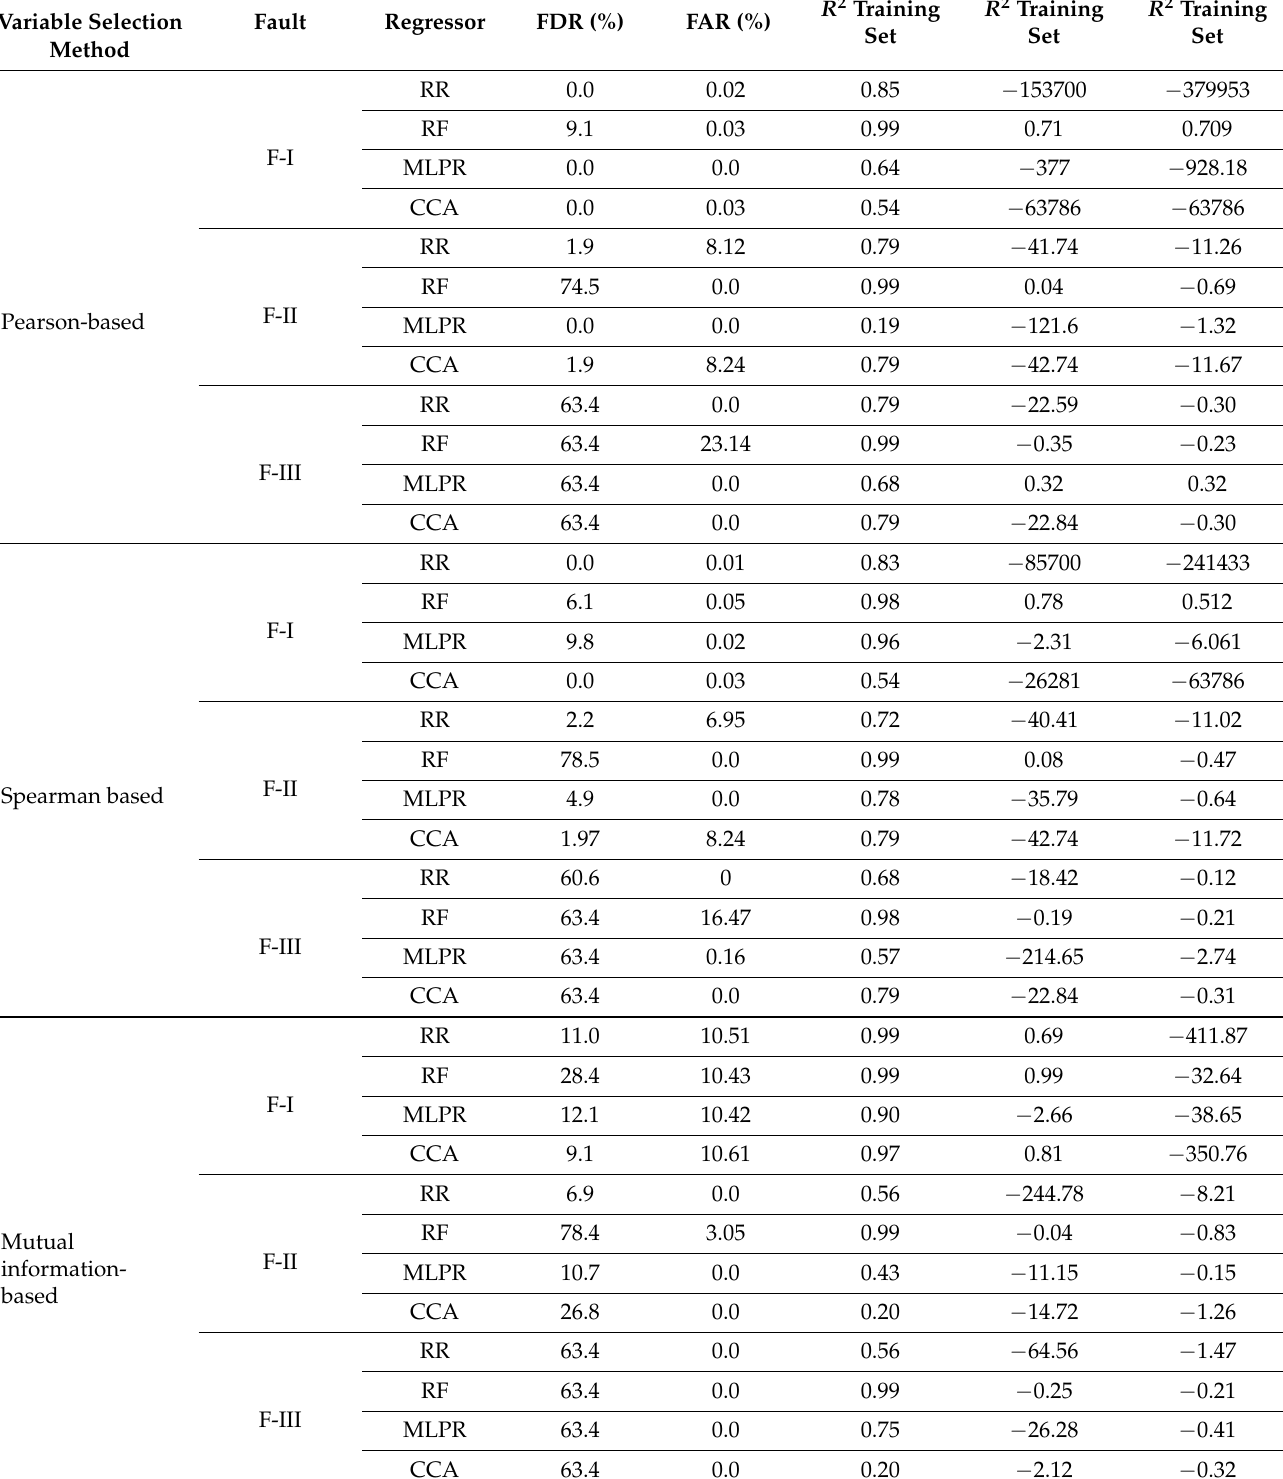
Table 7. Performance when filter-based variable selection procedures were used to analyze the industrial data. Variable